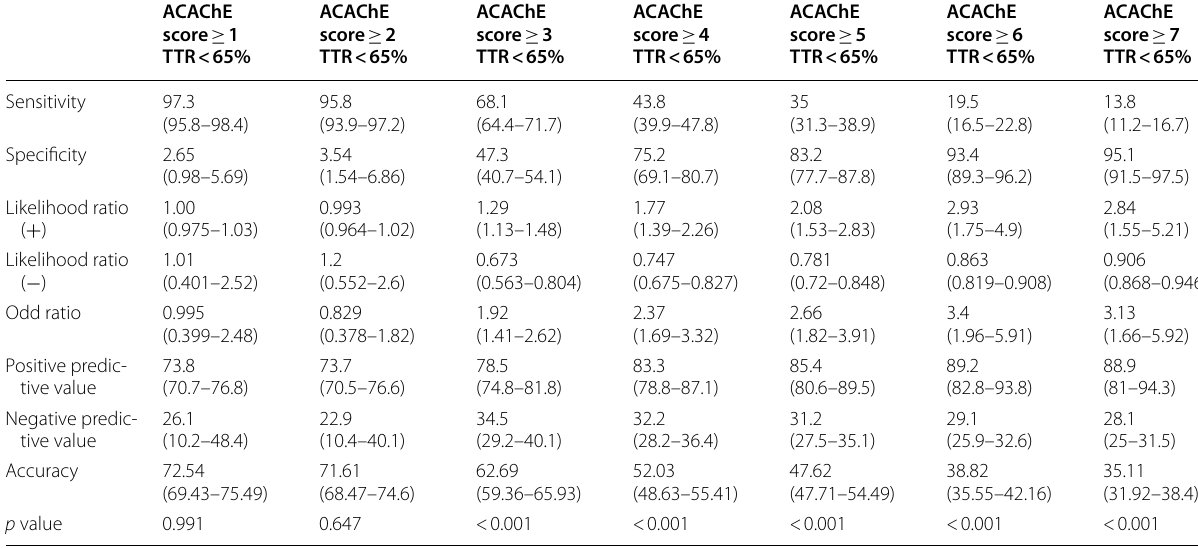
Table 4 Different cutoff points of the ACAChE score to predict poor anticoagulant control on warfarin (TTR <